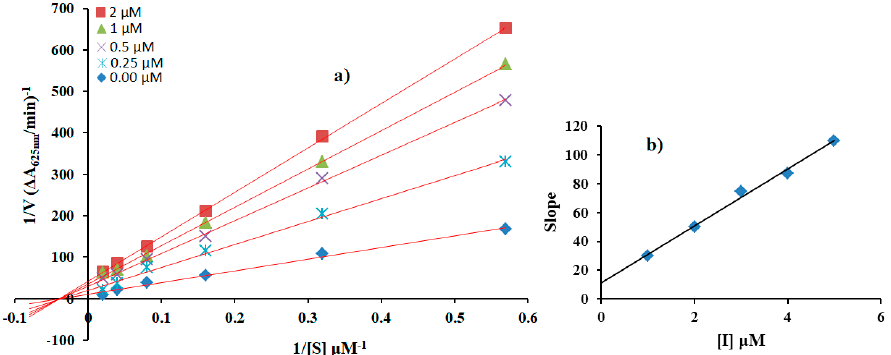
Figure 1. Kinetic analysis results for target molecule 3a . ( a ) Lineweaver-Burk plots for the inhibition of urease in the presence of compound 3a ; concentrations of 3a of 0, 0.25, 0.5, 1, and 2 µM, respectively. Substrate urea concentrations were 1.57, 3.12, 6.25, 12.5, 25, and 50 µM, used respectively; ( b ) The secondary replot of the Lineweaver-Burk plot, slope vs. various concentrations of 3a .